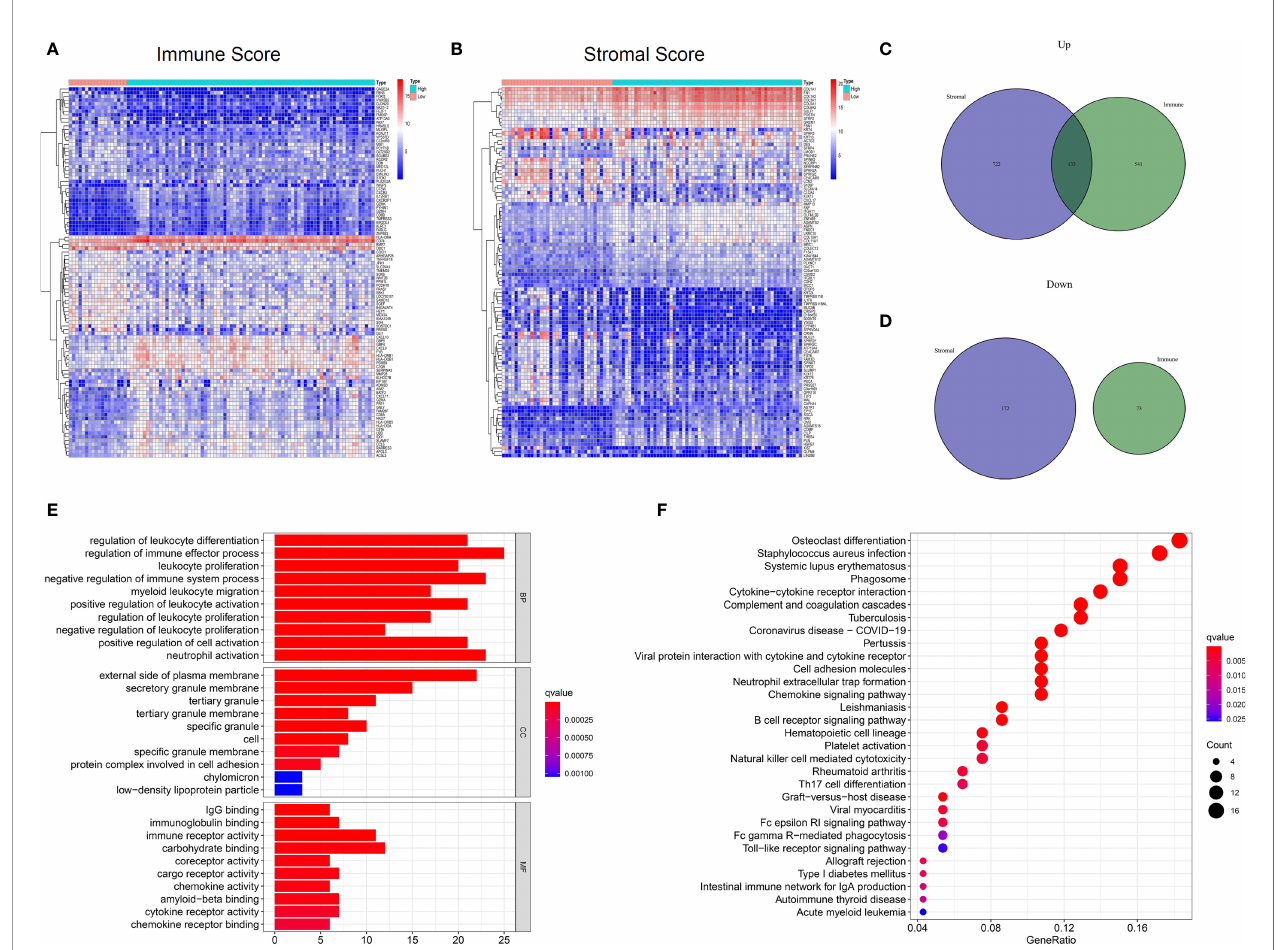
FIGURE 3 | Differential expressed genes identi fi cation and enrichment analysis of GO and KEGG. (A) Heatmap for DEGs between high and low Immuneacore groups. Row name of heatmap is the gene name, and column name is the ID of samples which not shown in plot. (B) Heatmap for DEGs in Stromalscore, similar with (A) . (C, D) Venn plots for common up-regulated and down-regulated DEGs shared by Immunescore and Stromalscore. (E) The top ten biological processes (BP) cellular components (CC) and molecular functions (MF) for GO analysis, respectively. (F) The top 30 KEGG enrichment signaling pathways for 133 DEGs, terms with p and q < 0.05 were determined to be enriched signi fi